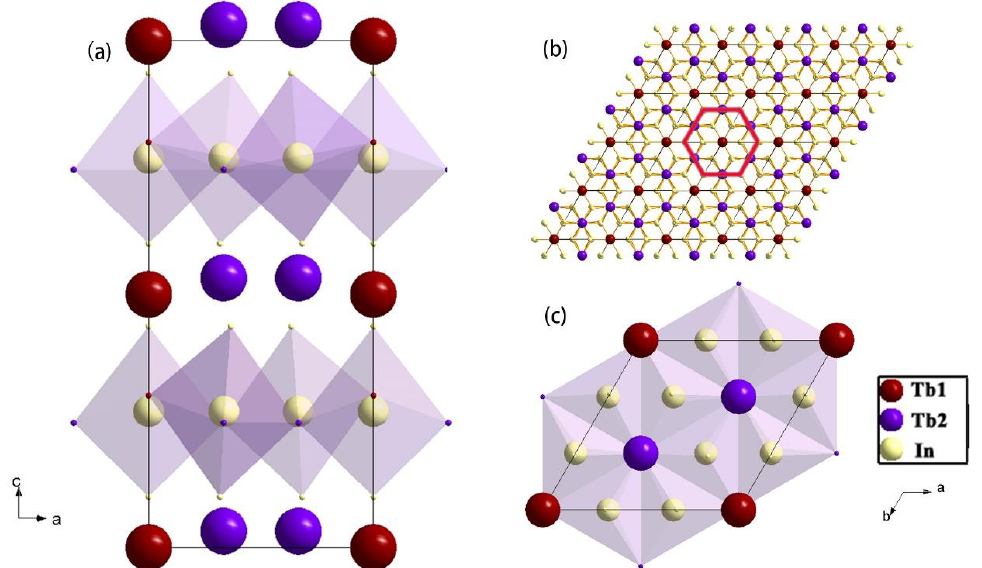
Figure 3. ( a ) Crystal structure of TbInO 3 in the [010] projection. Tb ions with two different sites (Tb1 and Tb2). ( b ) Tb 3+ ions form a two-dimensional hexagonal lattice in the ab plane. ( c ) Nearest-neighbor Tb1-Tb2 and Tb2-Tb2 pairs.